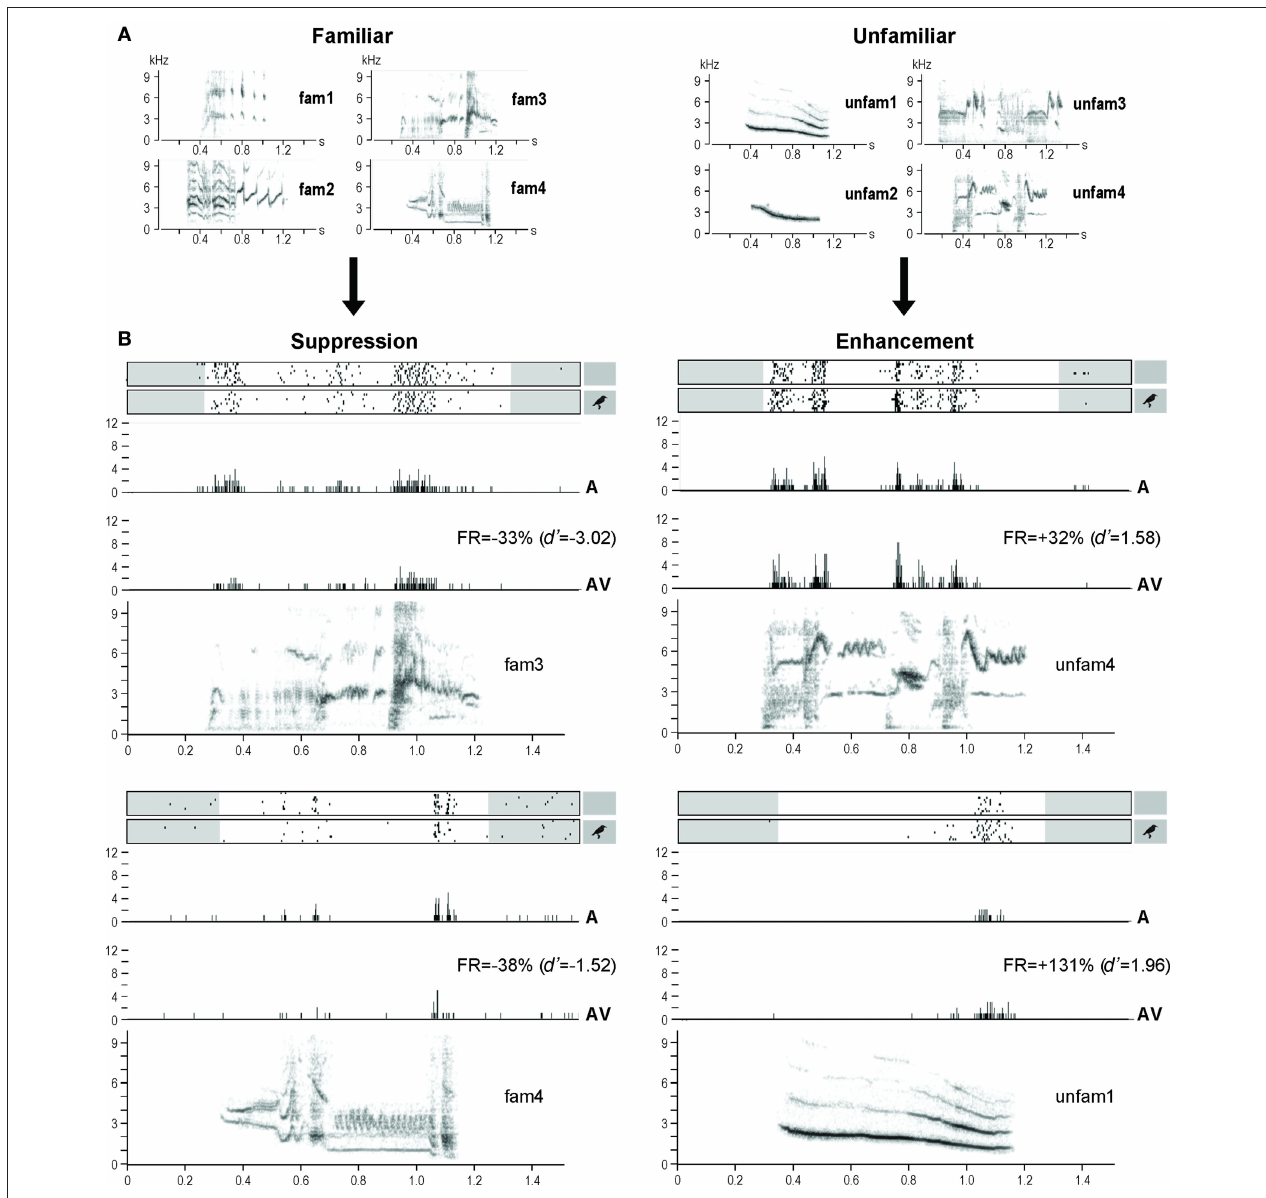
whether the acoustic stimulus was presented with – AV condition – or without – A condition – a visual stimulus), and as peri-stimulus time histograms (PSTHs) of the action potentials (that is, number of action potentials per 2-ms time bin) corresponding to the raster plots presented above. The sonograms of the acoustic stimuli ( x axis: time in seconds; y axis: frequency in kHz) are presented below the PSTHs. All traces are time aligned. FR, firing